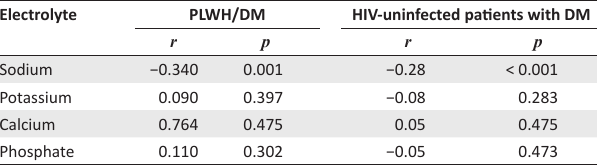
TABLE 2: Correlation of electrolytes and glycated haemoglobin in people living with human immunodeficiency virus and diabetes mellitus, and human immunodeficiency virus-uninfected patients with diabetes mellitus. Electrolyte PLWH/DM HIV-uninfected patients with